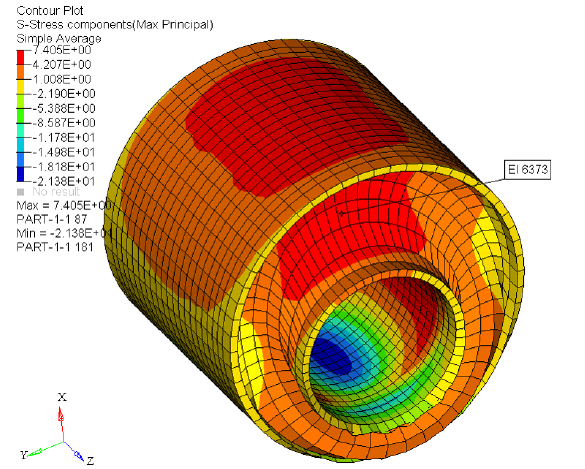
Figure 13. JLR toolbox: preliminary